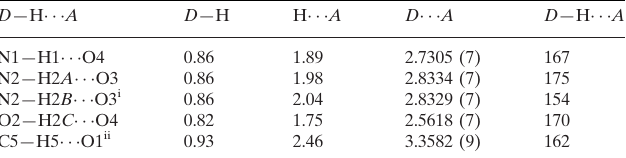
Hydrogen-bond geometry (A˚ , (cid:4)